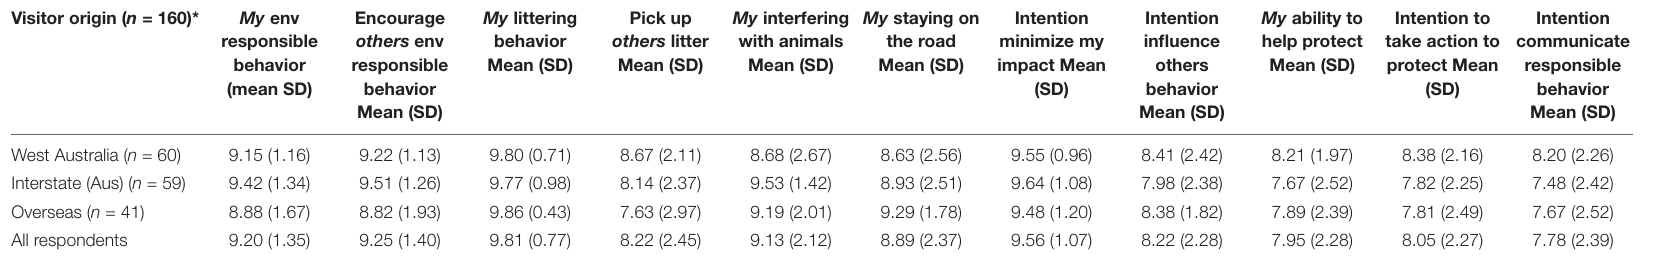
Scores are based on a Likert scale between 1 (representing strongly disagreed) and 10 (representing strongly agreed). *Three respondents did not identify their